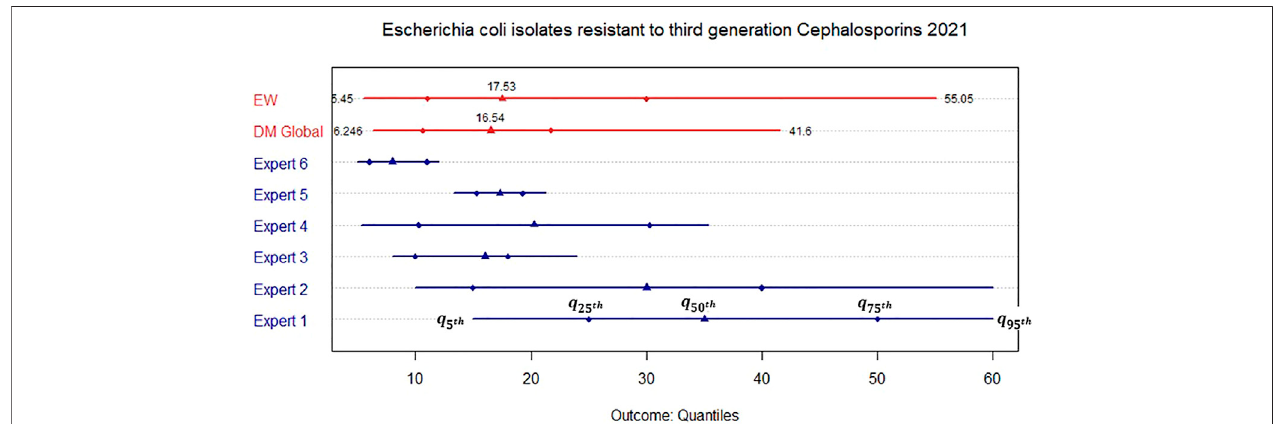
FIGURE 3 | Elicited marginal distribution (5 th , 25 th , 50 th , 75 th , and 95 th quantile) for the rate of resistance of Escherichia coli isolates resistant to third generation Cephalosporins in the United Kingdom in 2021.